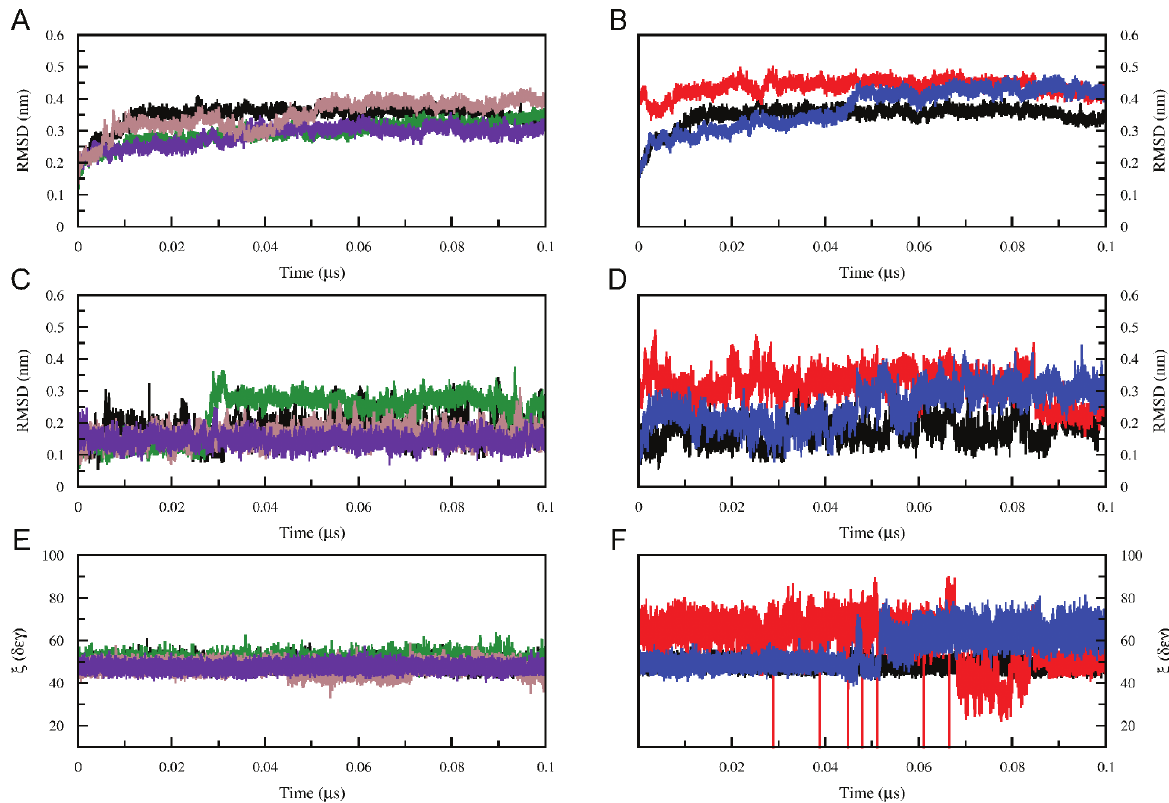
Figure 3 - MD analyses as a function of time in relation to the starting X-ray-derived model for System 1 (brown), System 2 (indigo), System 3 (black), System 4 (blue), System 5 (red), and System 6 (green) considering the following properties: root mean square deviation (RMSD) for entire protein (A) and (B), and for residues of C-terminal α-helix (C) and (D). Average pseudo dihedral ξ (i.e. the dihedral formed by 4 consecutive α-carbon atoms Cαi, Cαi α-helix (E) and (F), for which the reference value for a α-helical content is around 45° (see Section 3.2 for further